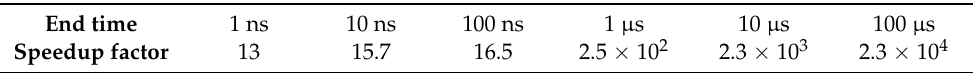
Table 2. Speed-up factor of the compartment-based model compared to the particle-based SBS model for different simulation end times from 1 ns to 100 µ